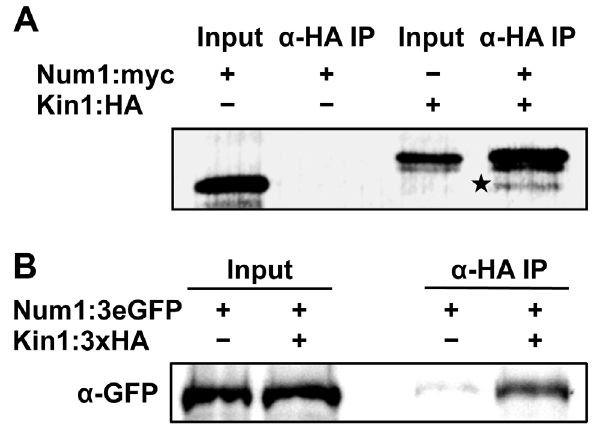
Figure 5. Num1 physically interacts with the Kin1 motor protein. ( A ) In vitro expression and co-immunoprecipitation of Myc- tagged Num1 and HA-tagged Kin1. Proteins were labeled with biotin during in vitro synthesis, detected with streptavidin-conjugated alkaline phosphatase, and visualized with NBT/BCIP. In the negative control (Num1:Myc), no unspecific binding of Myc-tagged Num1 to the HA- antibody was detected. In contrast, after co-incubation with HA-tagged Kin1, the Myc-tagged Num1 protein was co-immunoprecipitated (indicated by asterisk), demonstrating that the Num1 protein physically interacts with Kin1 in vitro . ( B ) In vivo co-immunoprecipitation of U. maydis strains expressing HA-tagged Kin1 and 3eGFP-tagged Num1 under control of their endogenous promoters. After crosslinking of proteins using DSP, a -HA coupled agarose beads were used to precipitate Kin1. The Num1 protein was detected on Western blots using an a -GFP antibody. As negative control, a strain expressing only Kin1:3 6 HA was used.